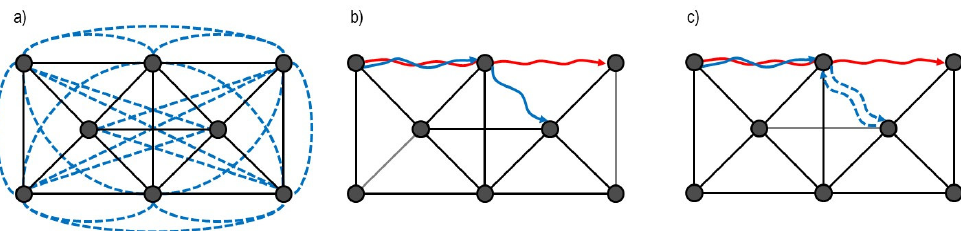
Figure 4. Influence of cognitive biases and engineering judgement on engineering knowledge. ( a ) Experience, intuitions and aggregate (a priori) knowledge; ( b ) Role of cognitive biases potentially influencing experience; and ( c ) Role of engineering judgement in assessing the validity of our con- clusions and intuitions.